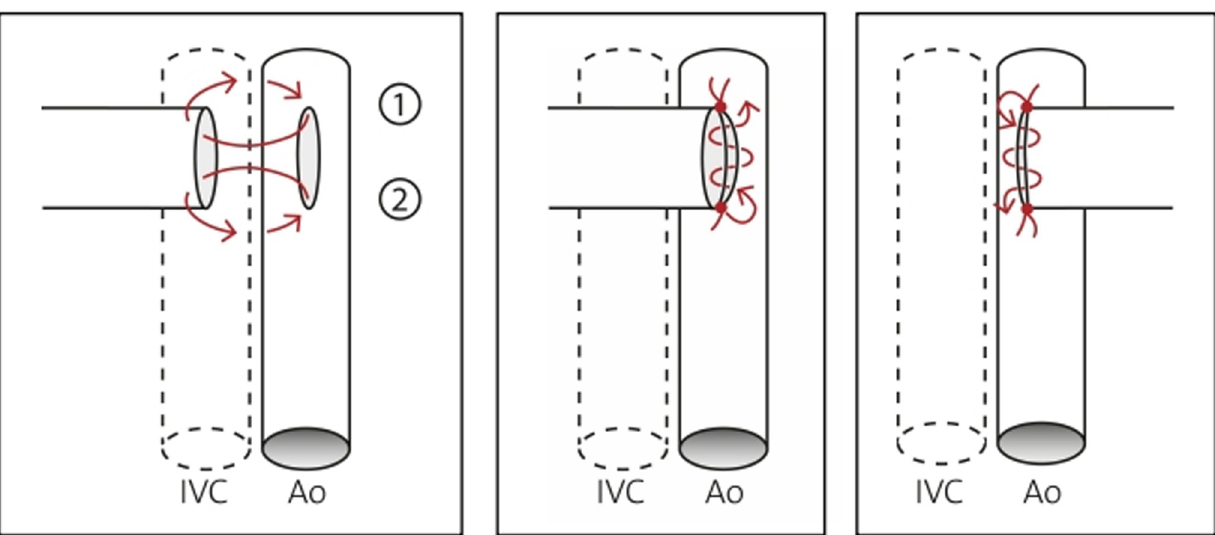
Fig 5. a-c: Schematic illustration of the arterial anastomosis on the abdominal aorta (Ao), while the broken line indicates the inferior vena cava (IVC). Fig 5A shows the proximal and distal anchor stitch. Fig 5B shows the continuously running suture on the left side from the distal anchor stitch towards the proximal anchor stitch. Fig 5C shows the right side of the arterial anastomosis after the heart was carefully flipped over to the left side of the abdomen.